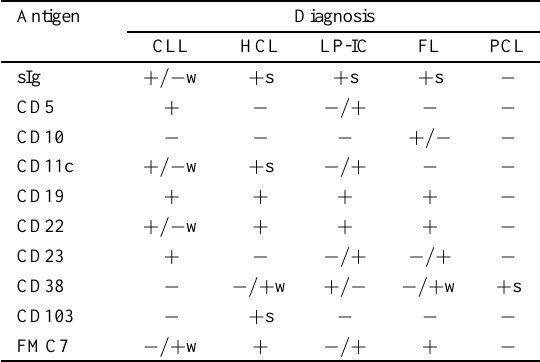
Immunological characterization of B-cell derived lymphoprolifera- tive malignancies (according to Rothe et al.